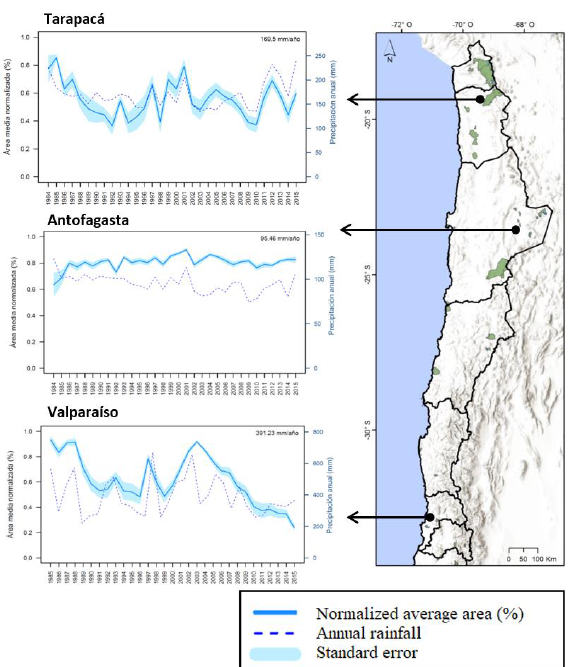
Figure 5. Parincota wetland, Isluga Volcano National Park. Comparison of the calculated annual series between the spectral indexes and the GSW product.